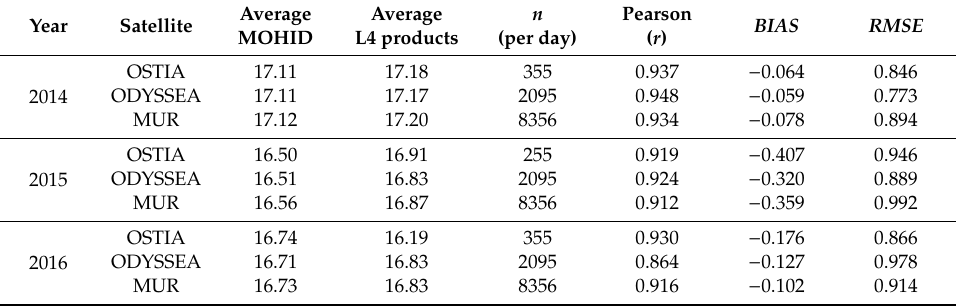
Values in Table 5 represent the mean of the statistical parameters for the entire study domain, but by plotting the spatial distribution of errors it is possible to observe where the di ff erences are found. Figure 10 shows that these di ff erences ( BIAS and RMSE ) are more noticeable within the estuary and nearshore, in particular for OSTIA and MUR products that cannot capture the SST gradient. This can also be observed in Figure 8. MOHID and ODYSSEA present a similar distribution pattern of the ◦ di ff erences, with BIAS always below 1 C, including in the estuarine